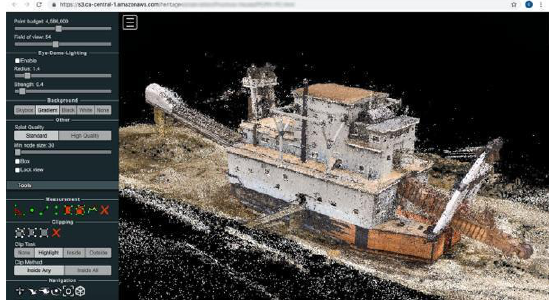
Figure 7: Point cloud project presented in an HTML format.